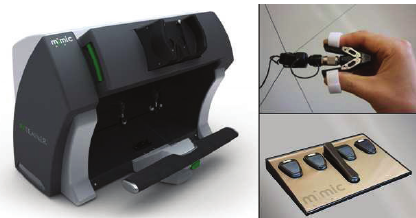
Figure1:ThedV-Trainer(showingconsole,grips,andpedals(image provided by Mimic Technologies, Inc., Seattle, WA)).